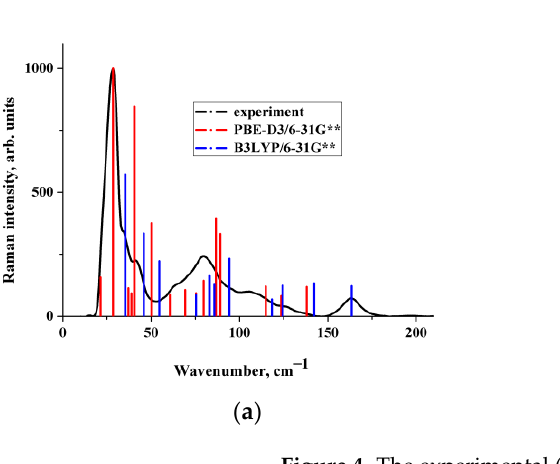
Figure 5. The experimental (black line) and calculated (PBE-D3 — red sticks and B3LYP — blue sticks) low-frequency Raman spectra of the [2AmNic+Mle+H 2 O 2 ] crystal ( a ). The theoretical values of wavenumbers are scaled by 0.9. The height of the bars is proportional to the relative Raman intensity of the corresponding transition. The schematic representation of the atom displacements of the two Raman intense vibrations (PBE-D3/6-31G**) at 44 cm −1 ( b ) and 94 cm − 1 ( c ).